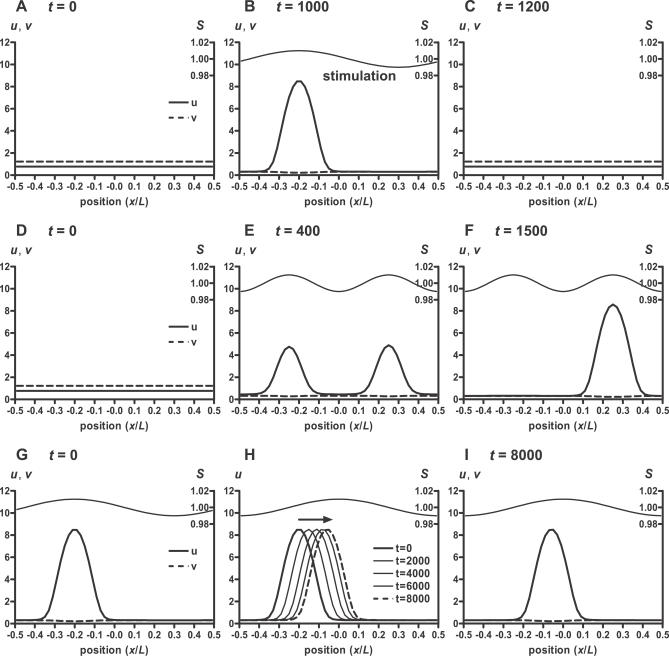
Behaviors of the Conceptual Model ISpatial profiles of u (solid lines) and v (dashed lines) are shown in (A–G) and (I). The thin line in (B) and (E–I) indicates the spatial profile of the stimulation.(A–C) Reversible accumulation of the components. We set S = 0.2 at t = −100, and ran the simulation until t = 0 to reach the stationary state (A). Then, the stimulation S = 1{1 + 0.01 cos[2π(x/L + 0.2)]} was given, and the simulation was run until t = 1,000 to reach the stationary state (B). The stimulation was reduced to the basal level (S = 0.2) again, and the simulation was run until t = 1,200 to reach the stationary state (C).(D–F) Multiple transient and a single stable accumulation peaks. Starting with the conditions in (A), we gave random perturbation (±0.02) to obtain the homogenous initial conditions (D). Then, at t = 0, the stimulation S = 1{1 + 0.01 cos[2π(x/L + 0.25) × 2]} was given, and the simulation was run for the indicated time (E,F). The stimulation points with the maximal intensity were at x/L = −0.25 and 0.25.(G–I) Sensing of the stimulation gradient by the polarized peak. We set S = 1{1 + 0.01 cos[2π(x/L + 0.2)]} at t = −1,000, and the simulation was run to reach the stationary state where the polarized peak was seen at x/L = −0.2 (G). The new stimulation S = 1{1 + 0.01 cos[2π(x/L)]} was given, and the maximal intensity point was shifted to x/L = 0. The simulation was run for the indicated time (H,I). The arrow indicates the direction of movement of the polarized peak (H).